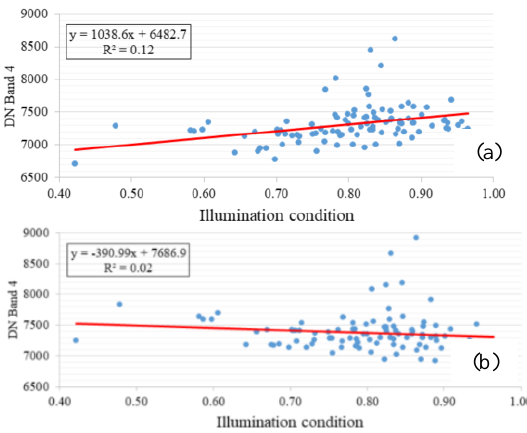
Figure 6. Reflectance of band 4, (a) before and (b) after topographic